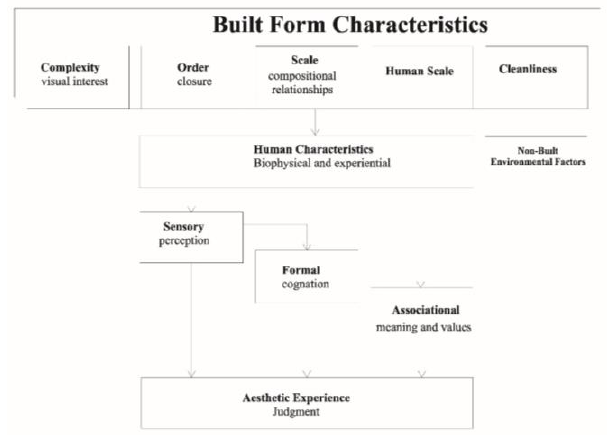
Figure 2. An analytical framework of environmental aesthetics (Adopted from Gjerde,